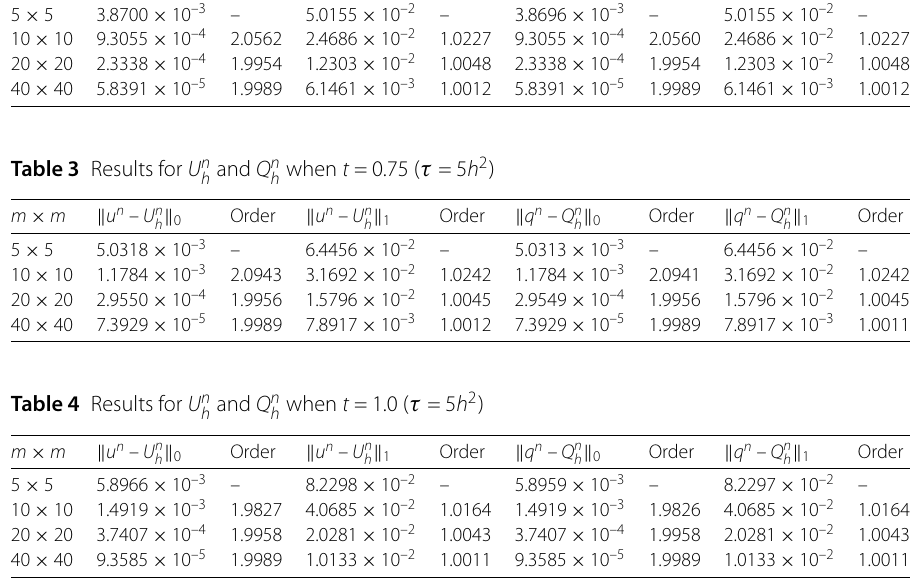
Table 2 Results for U n